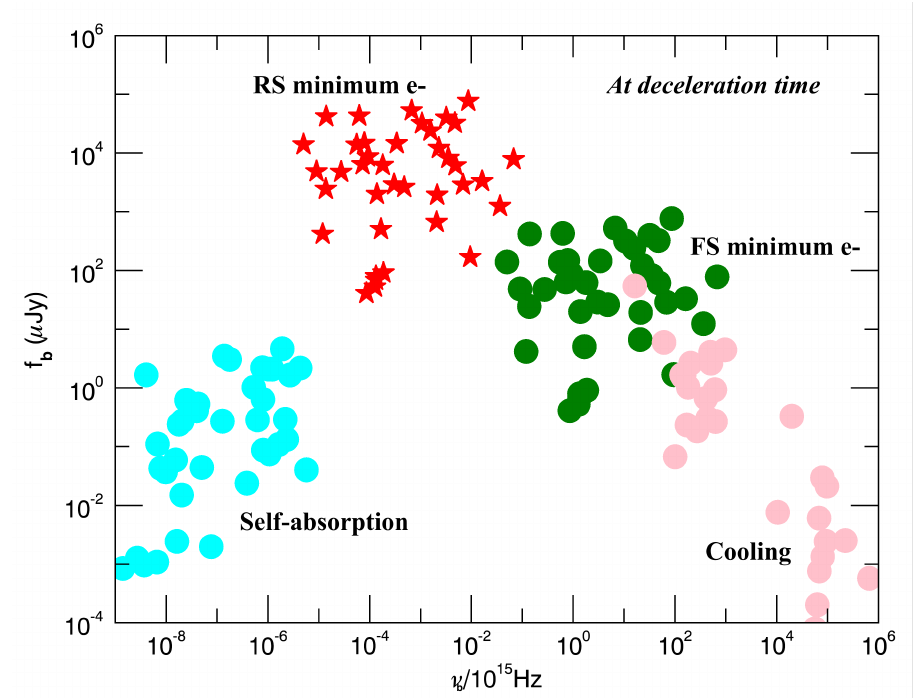
Figure 1. Flux at the characteristic frequency vs. characteristic frequency ν b (normalized to 10 15 Hz from a synchrotron spectrum in a standard external shock model, using data from Fong et al. [14], in which (cid:101) B = 0.01 was employed in their fits. The light blue dots indicate the forward shock self-absorption frequency ν a , the green dots the frequency corresponding to the minimum or characteristic electron energy ν m and the pink dots the so-called cooling frequency ν c . The red stars indicate the minimum or characteristic electron frequency for the reverse shock, ν m , RS